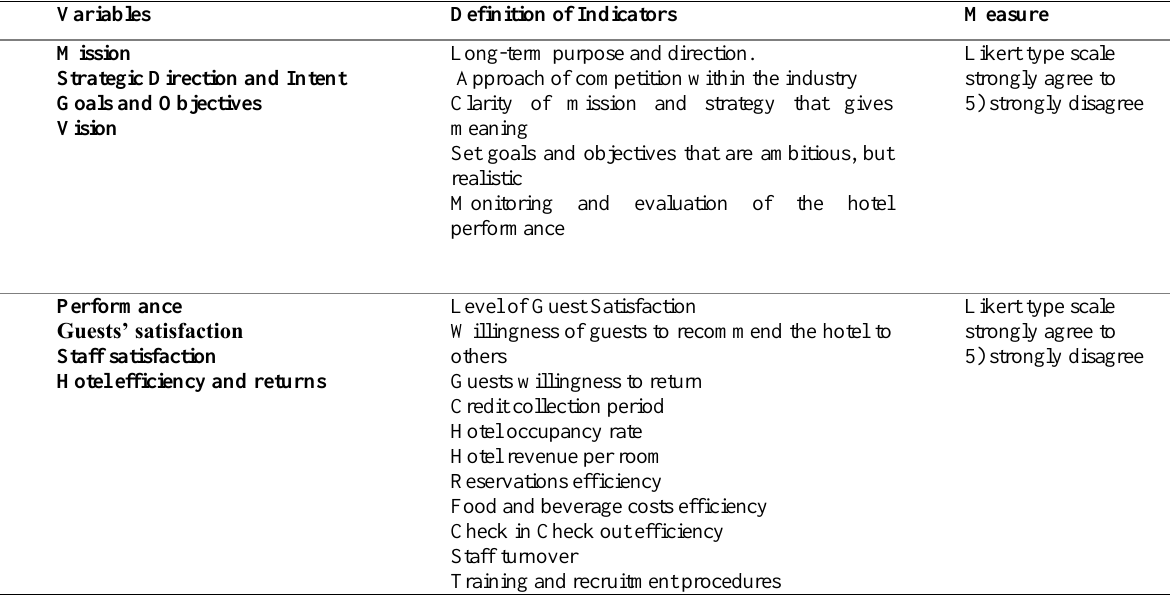
Table 1: Operationalization of study